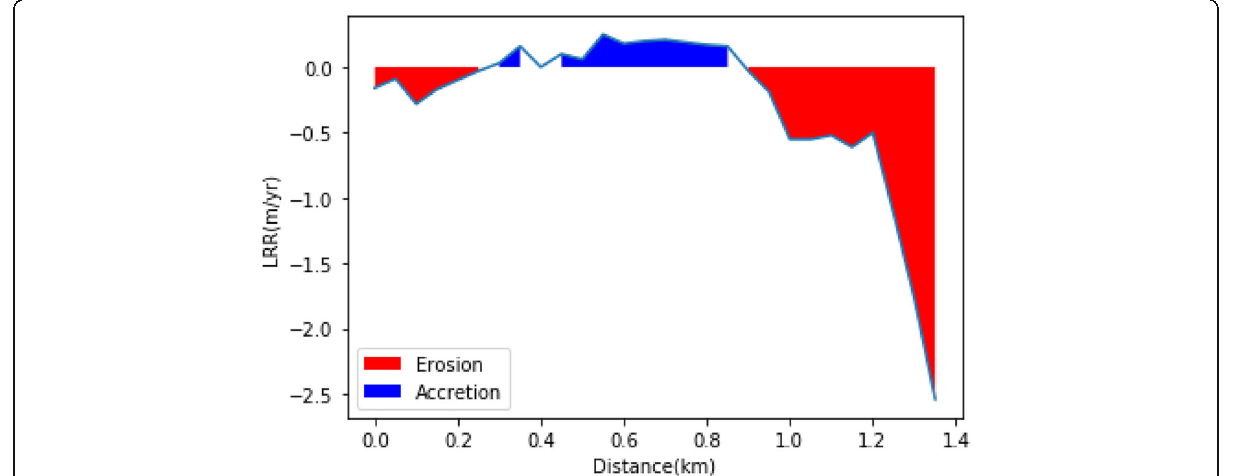
Fig. 8 Shoreline change for the western estuarine of the Volta